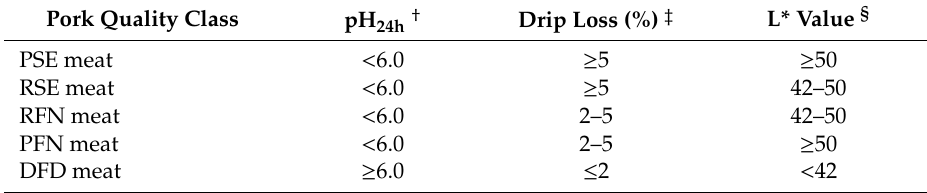
Table 1. Assessment of pork quality classes according to Ko´cwin-Podsiadła et al. [35]. Pork Quality Class pH 24h † Drip Loss (%) ‡ PSE meat <